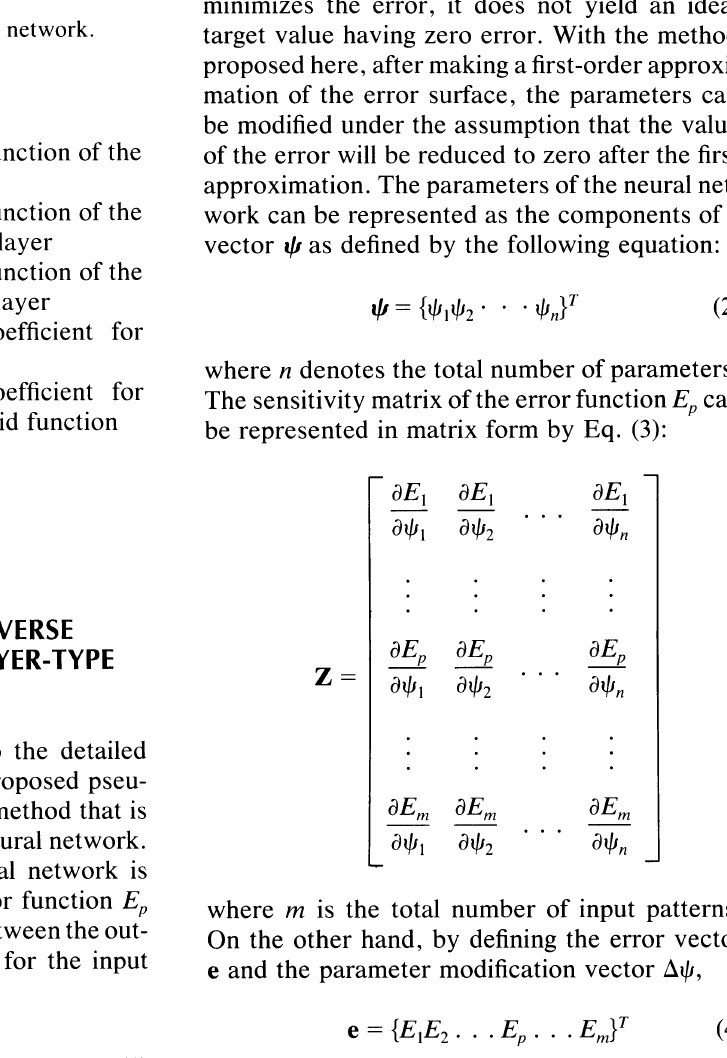
FIGURE 1 Three-layered neural